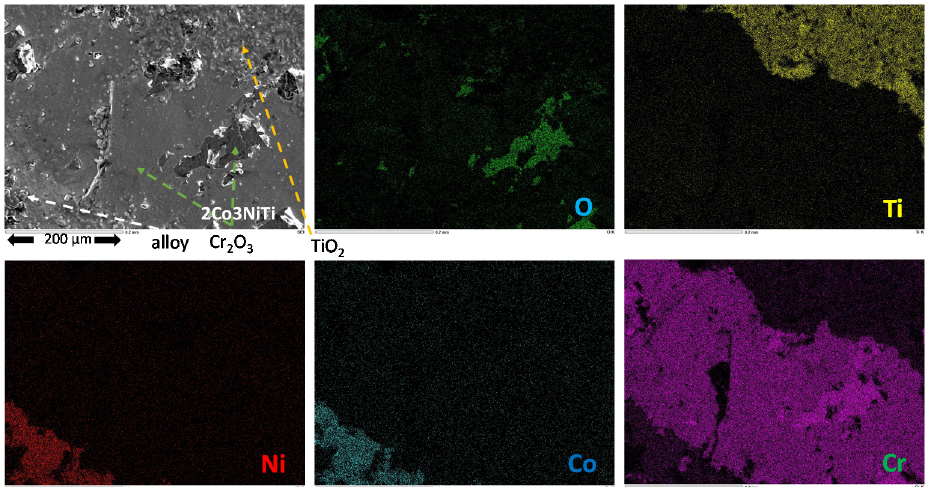
Figure 7. X-map obtained on the oxidized surface zone of the 3Co2NiTi alloy (evidencing the TiO 2 , CoCr 2 O 4 and Cr 2 O 3 zones).